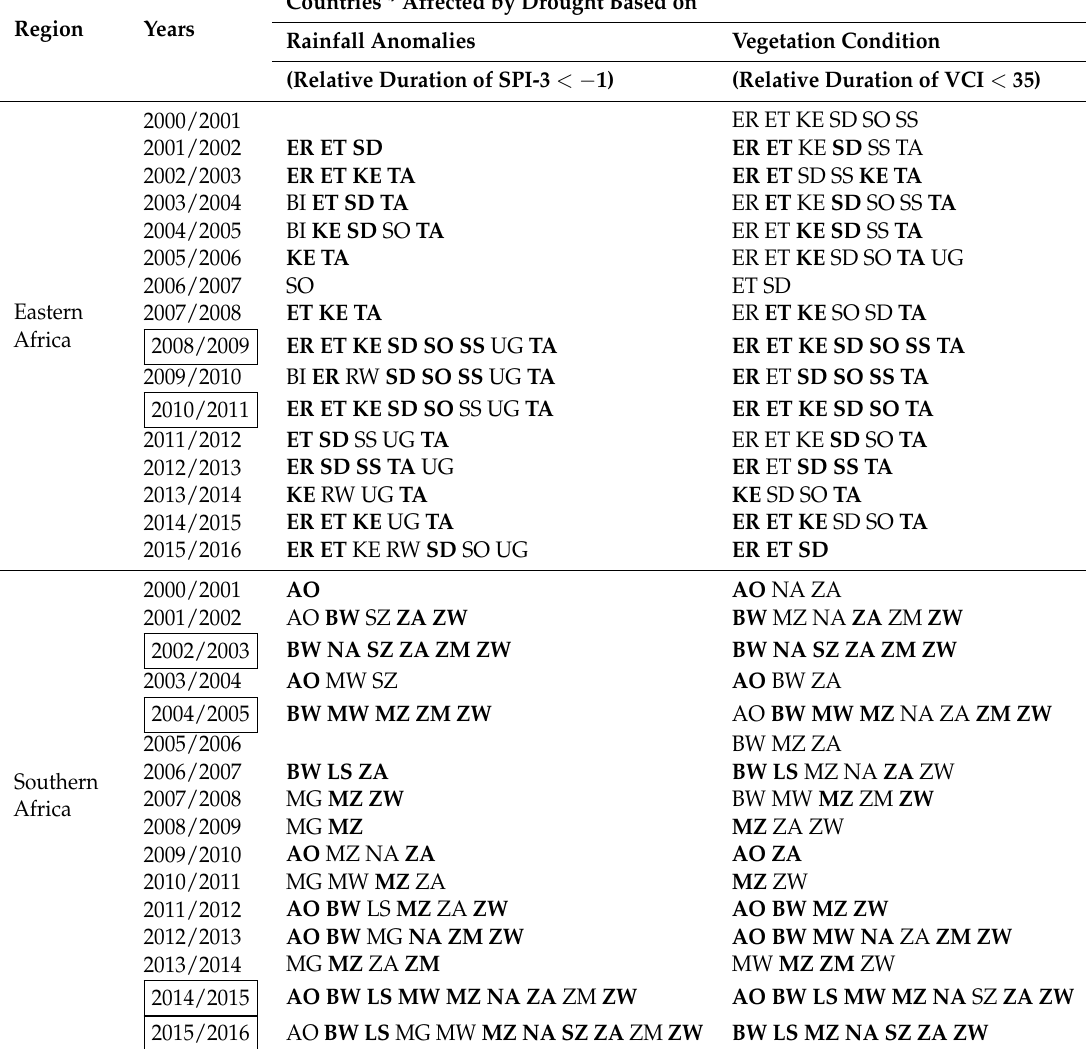
* Country codes: AO = Angola, BI = Burundi, BW = Botswana, ER = Eritrea, ET = Ethiopia, KE = Kenya, LS = Lesotho, MG = Madagascar, MZ = Mozambique, MW = Malawi, NA = Namibia, RW =